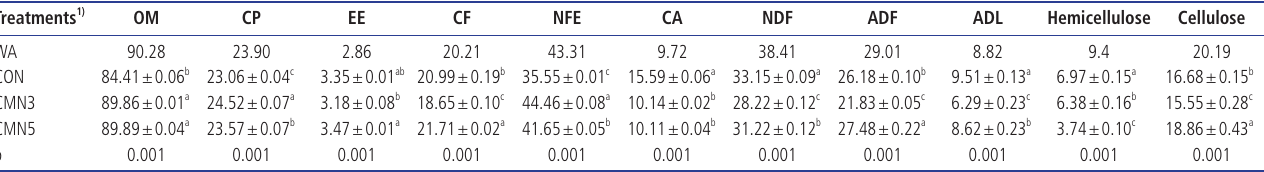
Table 3. Chemical composition of fresh alfalfa and silage ensiled for 120 days (% dry matter) Treatments